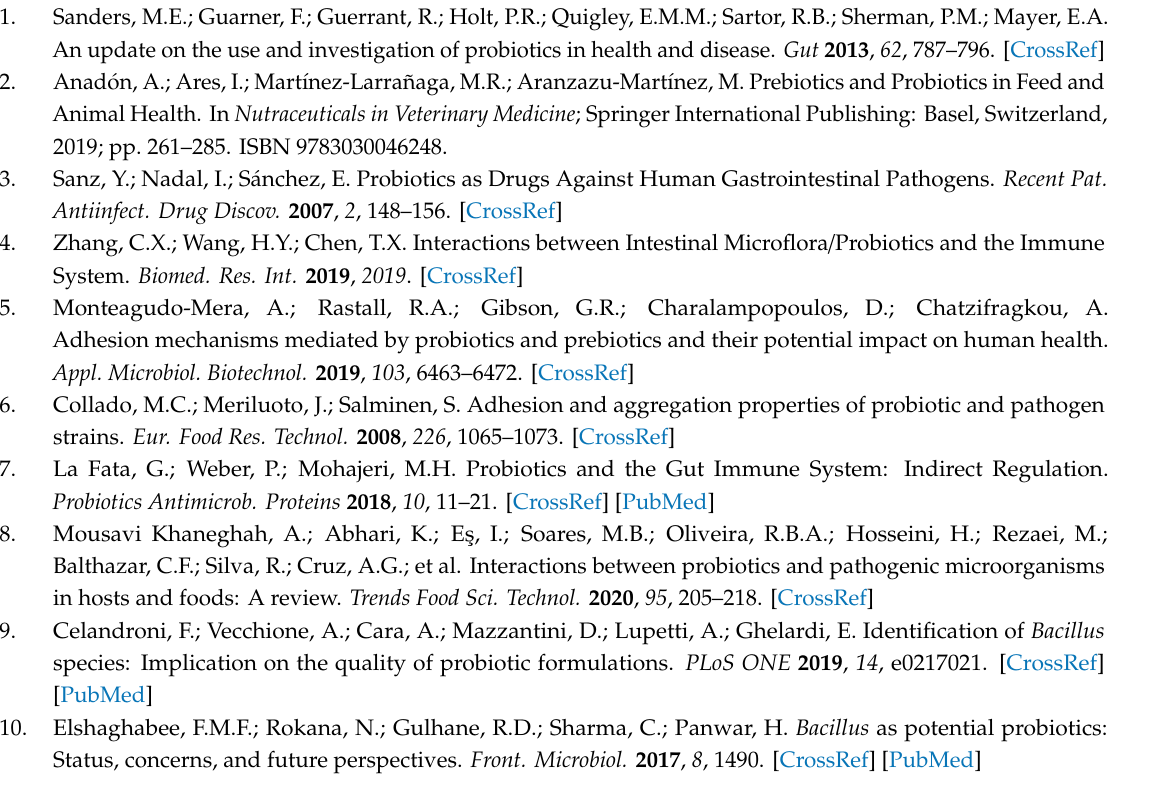
Figure S1: Quantification of MUC2 and MUC3 in HT29-16E cells after treatment with Bacillus subtilis strain CHCC